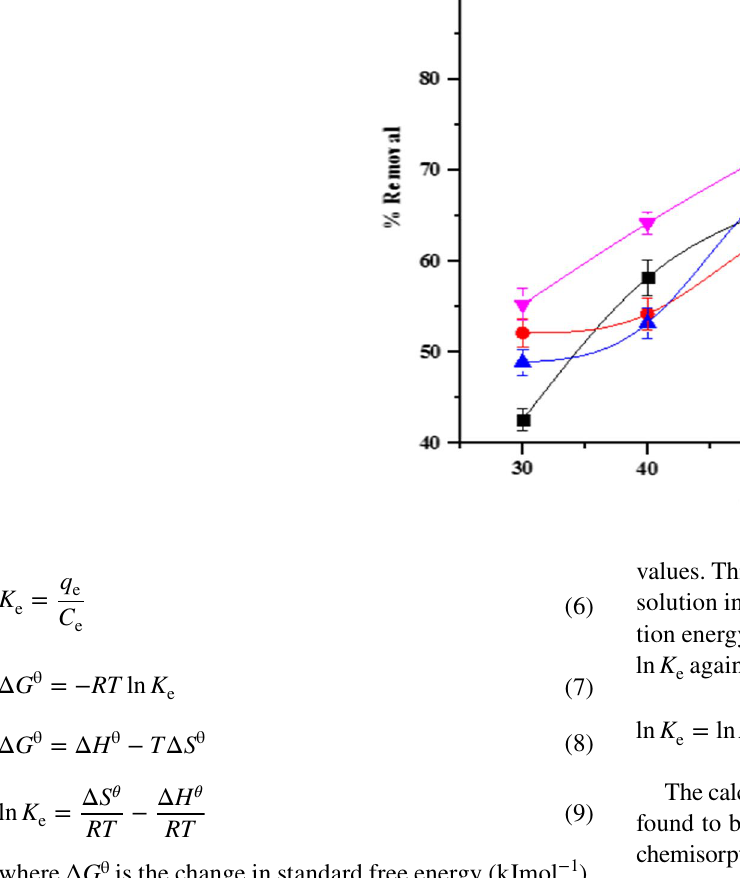
Fig. 9 Effect of temperature on the percentage removal of Pb(II), Cd(II), Zn(II) and Cu(II) onto Albizia lebbeck